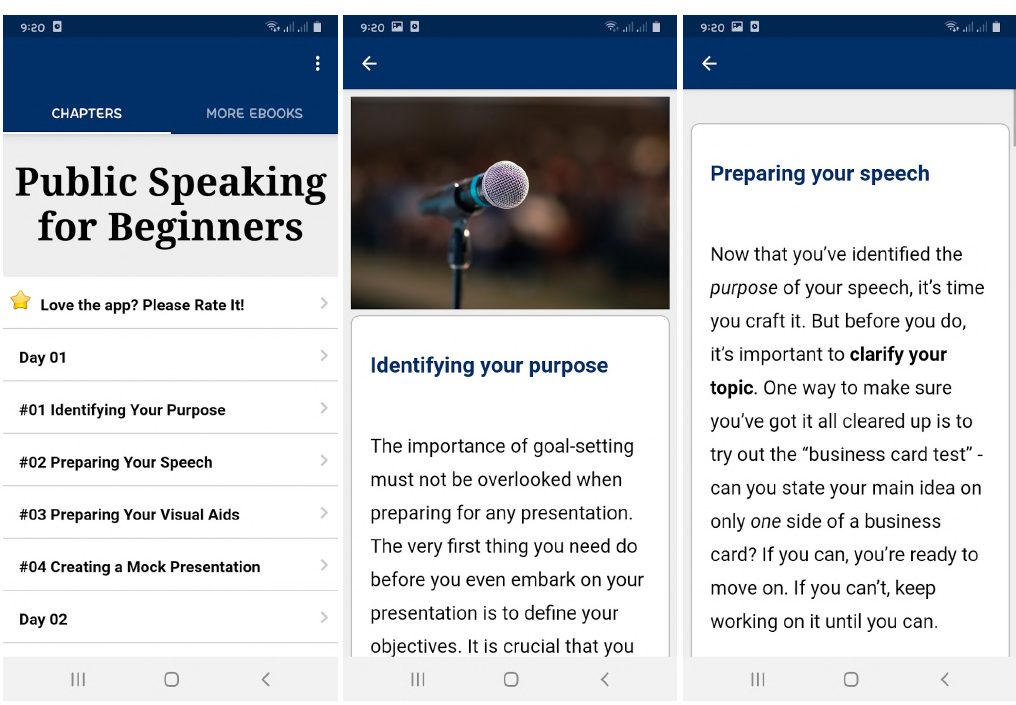
Figure 8: Public Speaking for Beginners